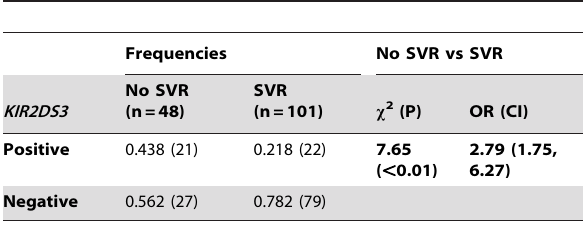
Table 3. KIR2DS3 gene frequency is increased in co-infected patients that fail to achieve SVR.